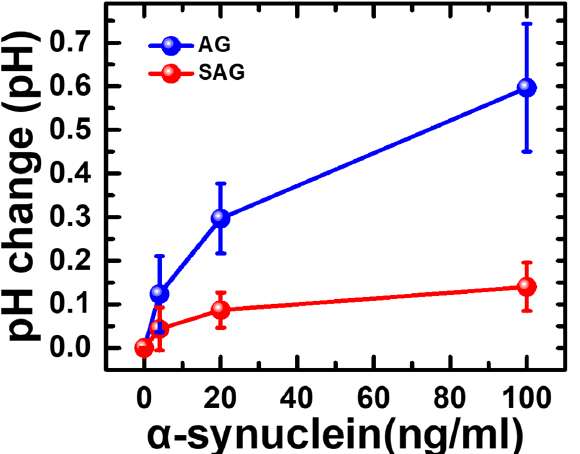
Figure 6. Endpoint pH change generated by the whole Proton-ELISA process for different concentrations of α-synuclein antigen and two different conjugated GOx in part #4 of the experiment.